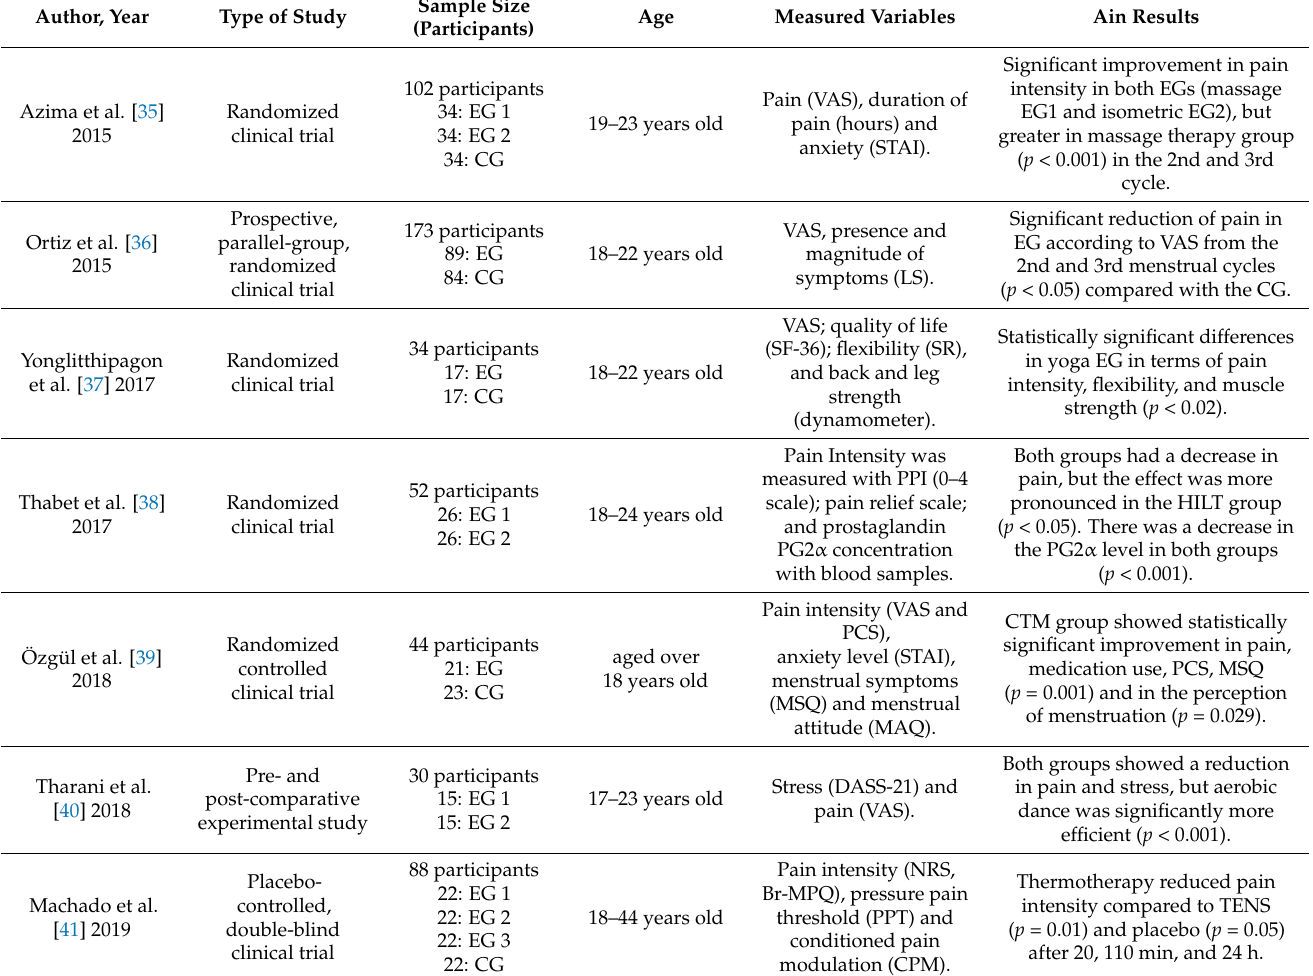
Table 2. Characteristics of the study and the